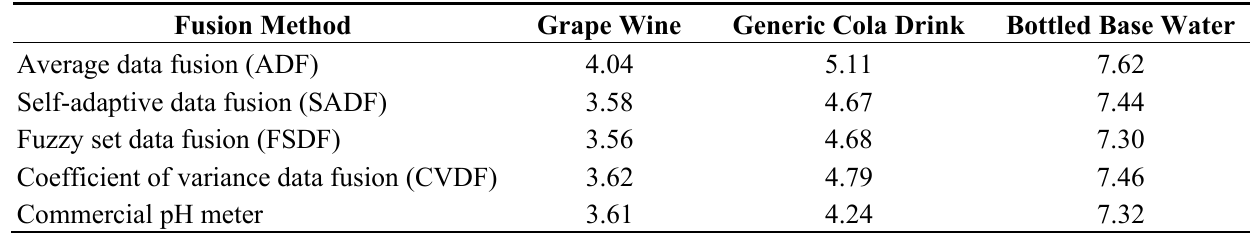
Table 7. Comparison of the fusion results with pH measured data fusion of grape wine, generic cola drink and bottled base water drinks with different data fusion